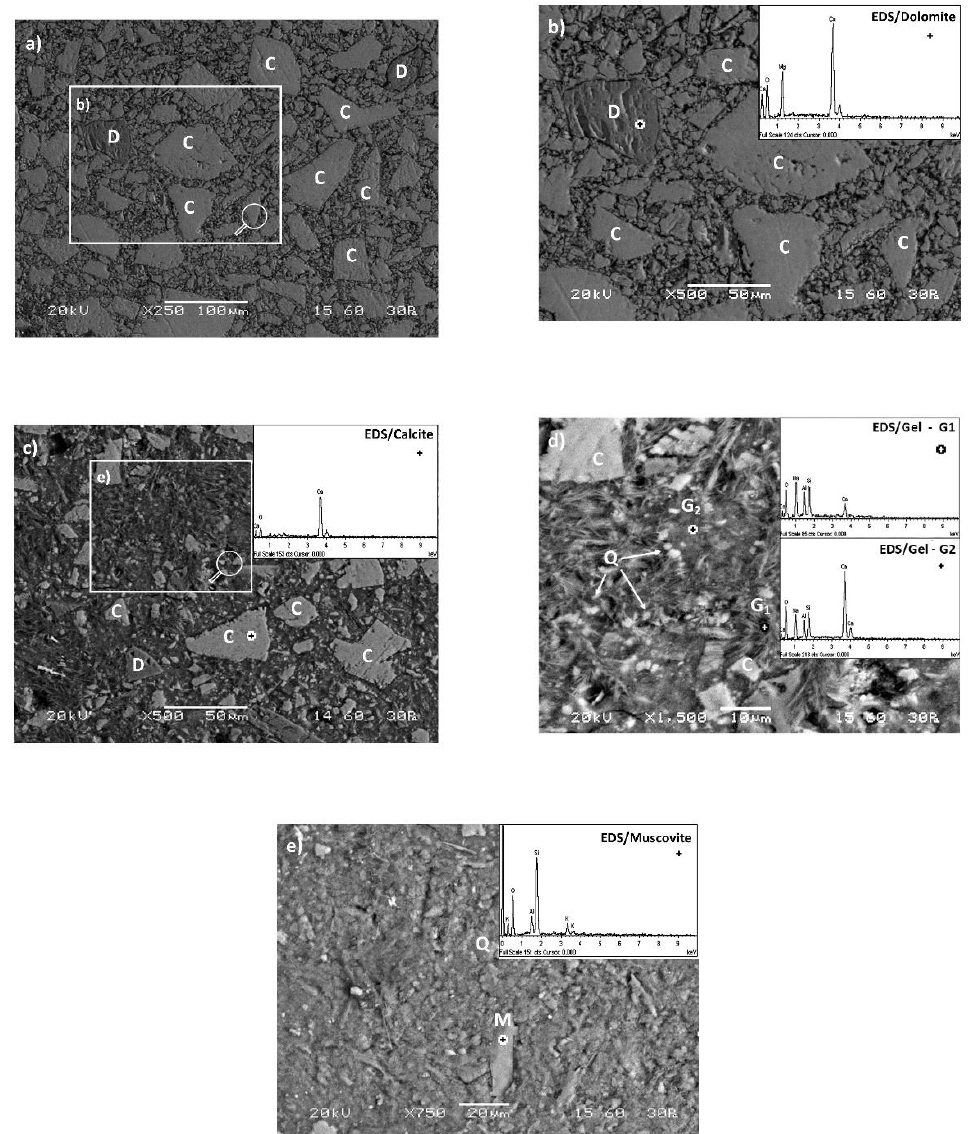
Figure 6. SEM-BSE images of polished cross-sections of selected AAMs produced under the optimum conditions (H 2 O/Na 2 O molar ratio 16, curing at 40 ◦ C for 24 h): ( a , b ) MW, ( c , d ) MW/MK 0.3 and ( e ) MK. EDS spectra show in several spot locations the presence of oxide phases, the formation of mixed aggregates and newly formed inorganic gels (C: Calcite, D: Dolomite, M: Muscovite, Q: Quartz, G 1 :Gel Na-rich, G 2 : Gel Ca-rich). On the other hand, the microstructure of the MW/MK 0.3 and MK AAMs is mainly characterized by smaller particles and the formation of a more homogenous polymeric network with less visible cracks compared to MW AAM (Figure 6c,d and e, respectively). However, the MK AAM is characterized by a more homogeneous and compact micro- structure due to the formation of a denser matrix in which very few unreactive particles are seen; this is due to the presence of metakaolin and the resulting higher degree of polymerization (Figure 6e). Figure 6d (zoom of rectangular area of Figure 6c) shows an improved pore refinement in the entire matrix of the MW/MK 0.3 AAM compared to MW AAM, due to the addition of metakaolin as precursor in the starting mixture, as well as fewer smaller in size unreactive particles that exhibit better cohesion with the precursors;